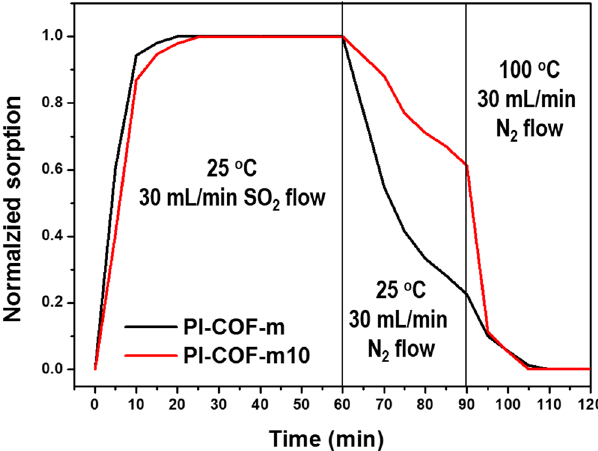
Figure 5. Desorption kinetics of PI-COF-m and PI-COF-m10 versus